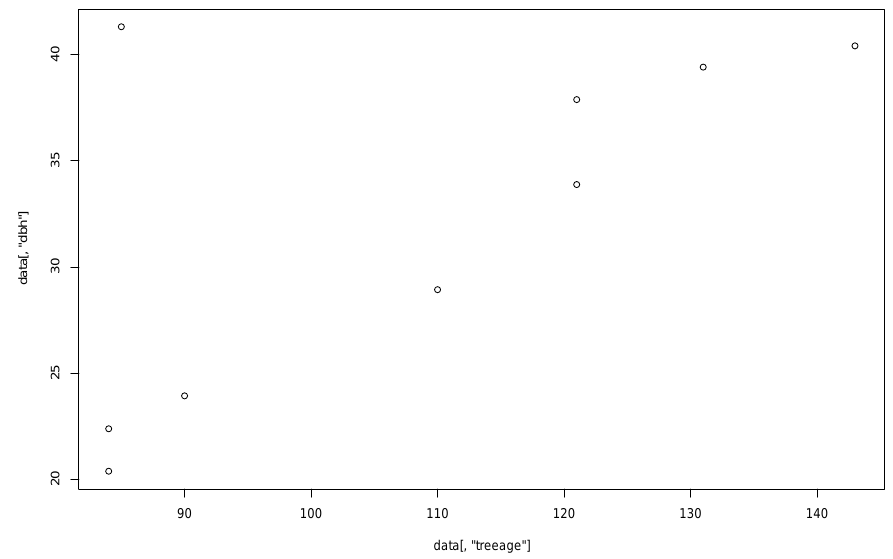
Figure 4: Result of ScatterPlot